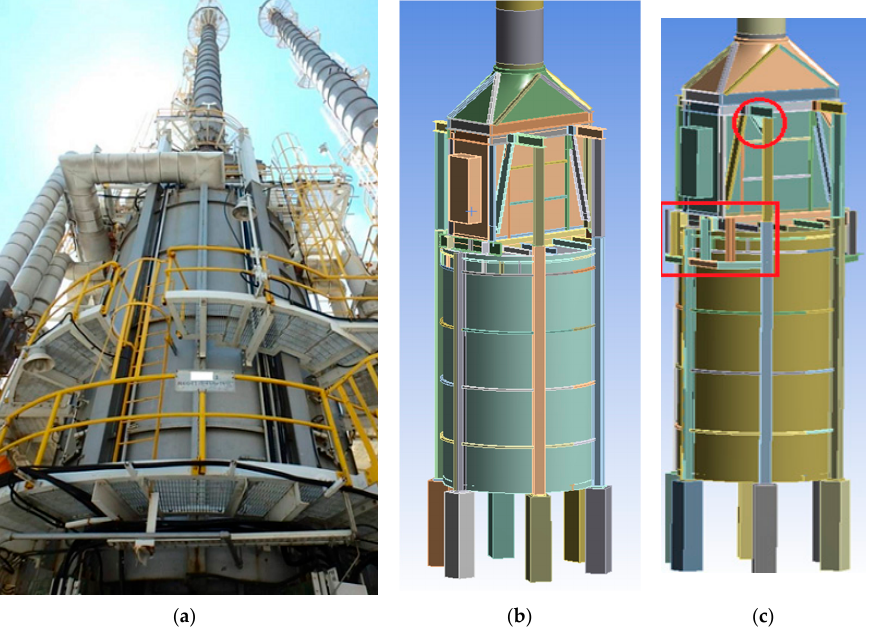
Figure 2. In Situ photograph and model of the heater. ( a ) in situ photograph, ( b ) model of original heater, ( c ) model of present heater (with reinforcement marked by circle and